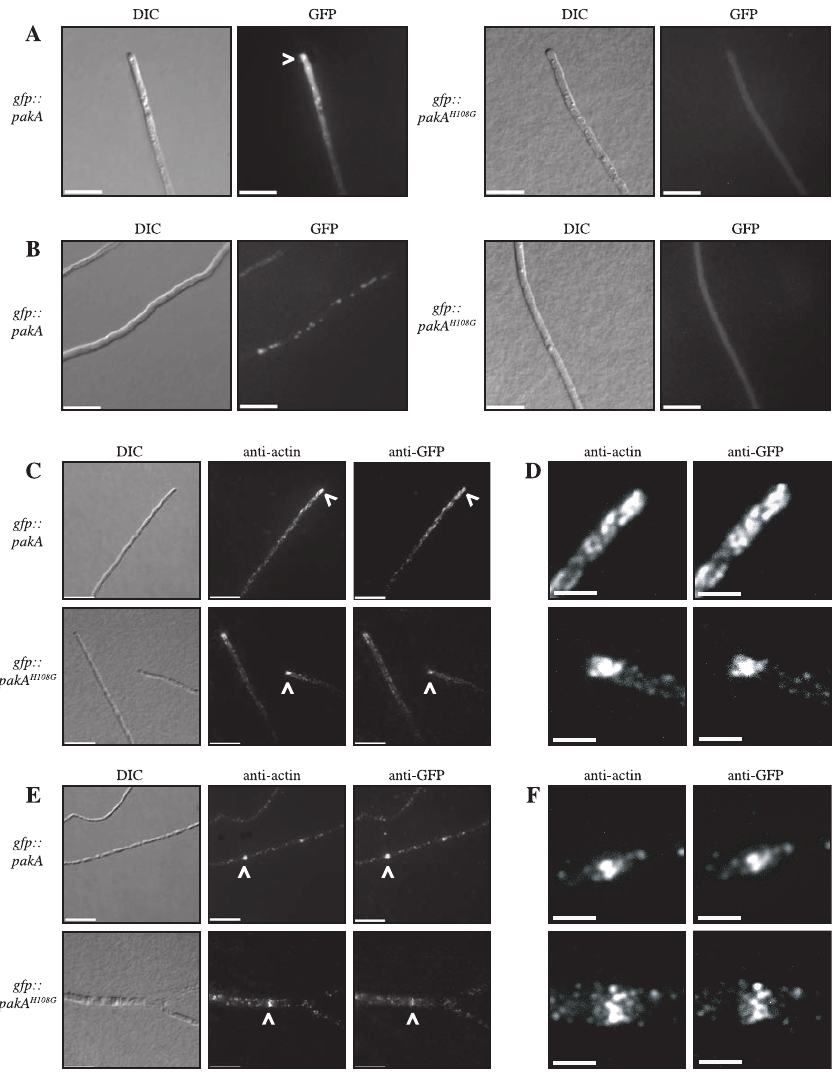
Localisation of PakA in live cells (A, B) and in immunofluorescently labeled fixed cells (C–F) at 25 8 C. (A) The GFP::PakA fusion protein is localised to the hyphal apex at 25 8 C (white arrowhead). In contrast, the GFP::PakA H108G fusion protein is visible throughout the cytoplasm. (B) In subapical hyphal cells, the GFP::PakA fusion protein is observed as spots along subapical hyphal cells. This localisation is not observed in the gfp::pakA H108G strains. (C) The PakA and PakA H108G GFP fusion proteins co-localised with actin at the hyphal tip (indicated by white arrowheads). (D) Enlargement of the stained region indicated by arrowheads in C. (E) At 25 8 C the PakA and PakA H108G GFP fusion proteins also co-localise with actin at nascent septation sites (indicated by arrowheads). (F) Enlargement of the stained region indicated by arrowheads in E. Images were captured using DIC or under epifluorescence to detect GFP, anti-actin, or anti-GFP. Scale bars, 20 l m. doi:10.1371/journal.ppat.0030162.g001 from phialides. The D pakA , D pakA pakA þ , and D pakA pakA H108G strains produced conidiophores with wild-type morphology (unpublished data).